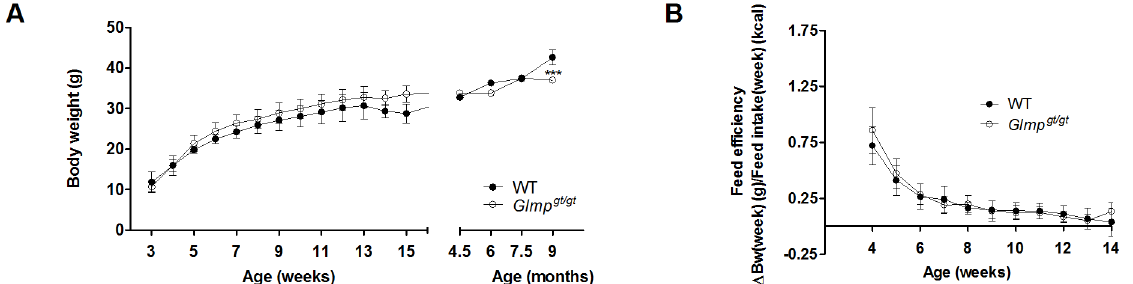
Fig 1. Loss of GLMP does not affect body weight gain and feed efficiency in young mice. (A) Body weight gain for male WT and Glmp gt/gt mice were monitored every week from 3 to 15 weeks of age, and then at 4.5, 6, 7.5 and 9 months of age. (B) The feed efficiencies of WT and Glmp gt/gt mice were monitored from 4 to 14 weeks of age (n = 27 – 31) ( *** p < 0 . 005 vs. WT). Values are presented as mean ±